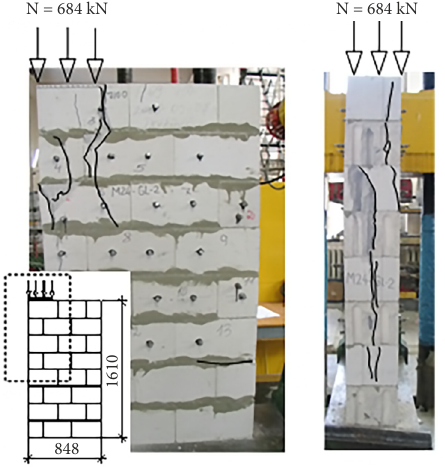
Figure 1. Failure mode of compressed masonry under bearing load 684